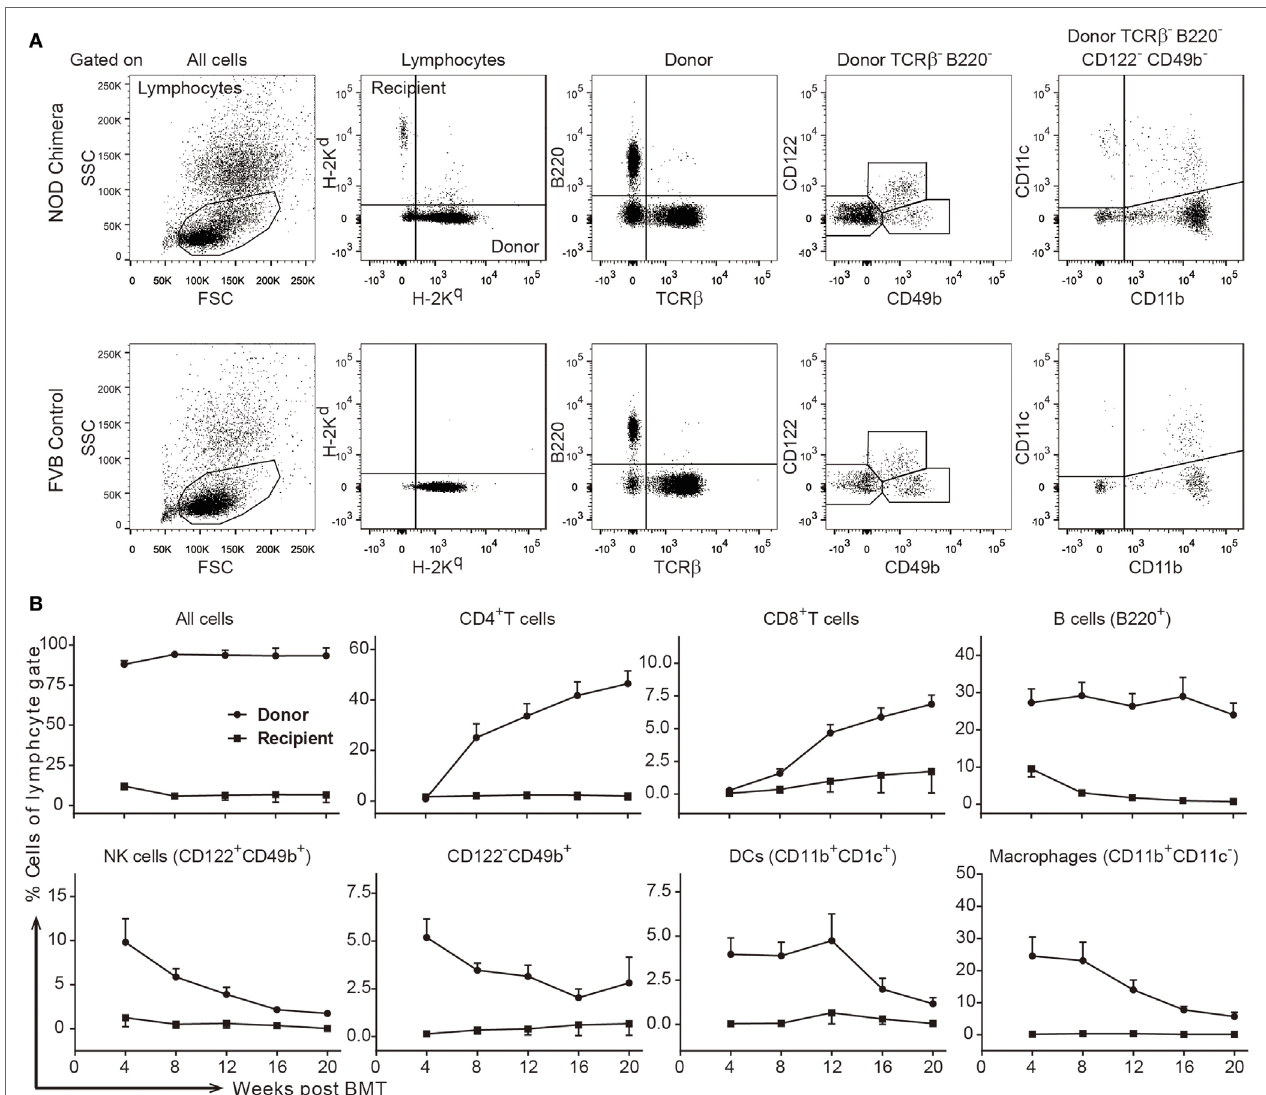
FigUre 3 | Stable high-level multilineage donor chimerism was maintained in FVB → non-obese diabetic (NOD) chimeras conditioned with a robust T cell depletion protocol. Stable chimeras (FVB → NOD; n = 11) induced by the triple antibody protocol (refer to Figure 2B ) were analyzed for different lineages of donor- and recipient-derived cells in peripheral blood lymphocytes (PBL) over time. (a) Shown is the gating strategy. (B) Shown are the percentages of donor- or recipient- derived major histocompatability complex-I + cells, CD4 + T cells, CD8 + T cells, B cells, NK cells, TCR β − B220 − CD122 − CD49b + cells, DCs, and macrophages in the lymphocyte gate in PBL over time. Values are shown as the mean ±